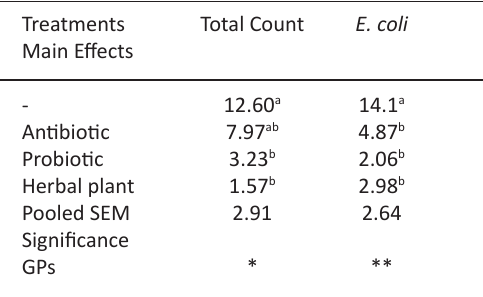
1 Values represent the means of 10 birds per treatments, ileoceacal digesta was taken from 2 birds per pen on day 25 under hygienic condition. GPs: Growth promoters, Antibiotic (Virginamycin), Herbal plant ( Thymus vugaris), SEM= Standard error of means, NS: Not-statistically significant. a-b, means within a column that do not share common superscripts have significant differences. *P ≤ 0.05, **P ≤ 0.01, ***P ≤ 0.001.